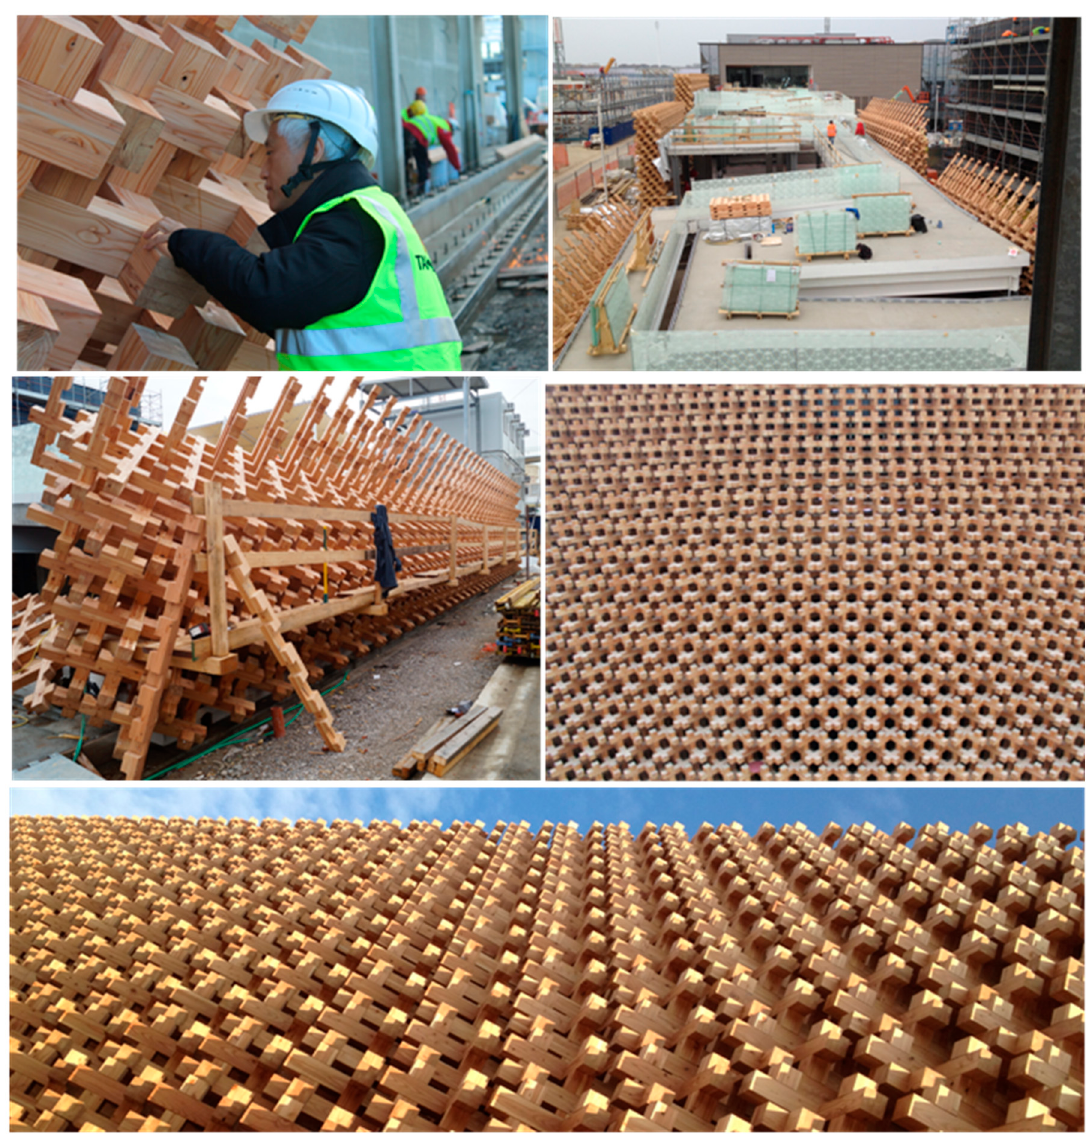
Figure 9. Views of the working phases (source: Galloppini Legnami).